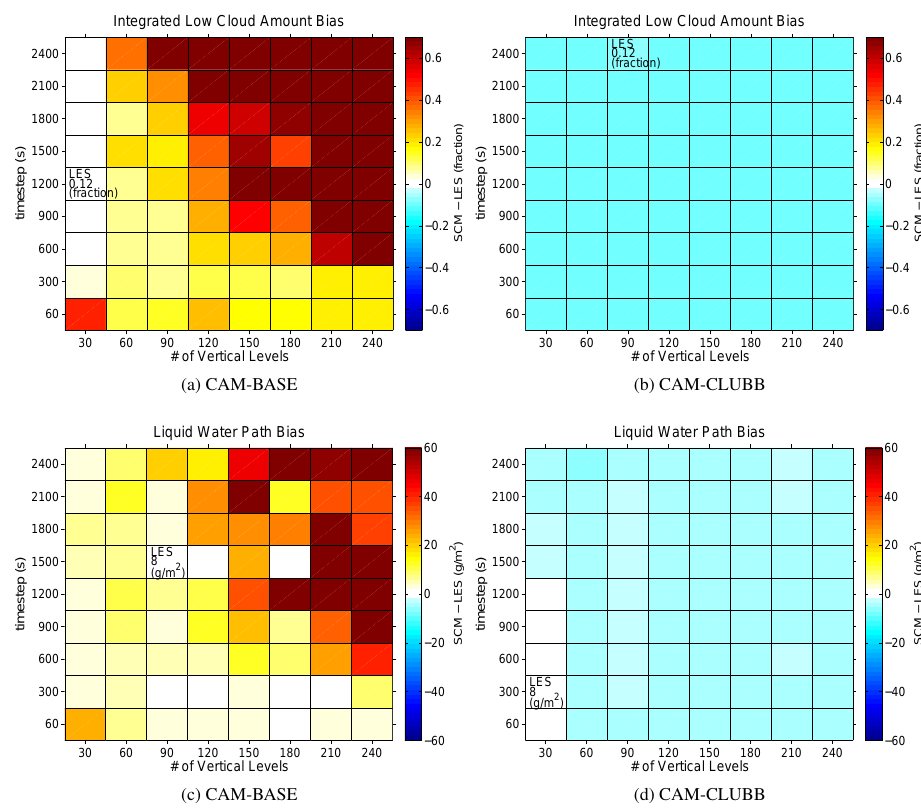
Fig. 1: Biases of vertically integrated low cloud amount (a, b) and liquid water path (c, d) from SCAM-BASE (a, c) and SCAM-CLUBB (b, d) . Displayed is the BOMEX case of nonprecipitating trade-wind cumulus, averaged over hours 4–6 of the simulation. Plotted in each cell is the bias computed with respect to LES for a different value of ∆ z and ∆ t . The cell marked “LES” indicates the configuration with the best match with the Large Eddy Simulation (LES) for the particular variable. The value in this box is the value computed by LES for this regime.